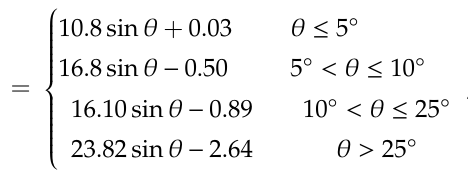
Figure 5. The K values and K r values for each soil types.